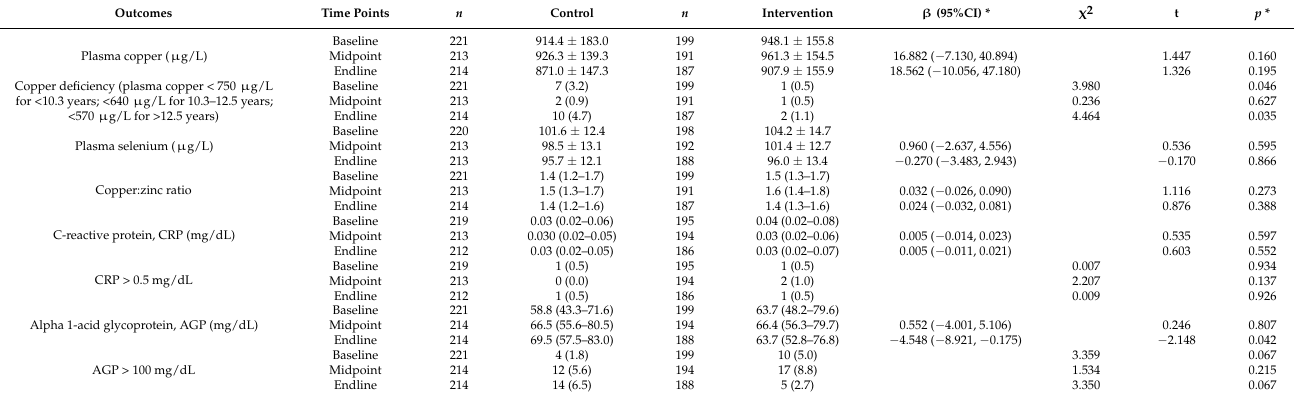
Table 7. Plasma copper and selenium concentration, and inflammation markers by study arm at baseline, midpoint and endline.